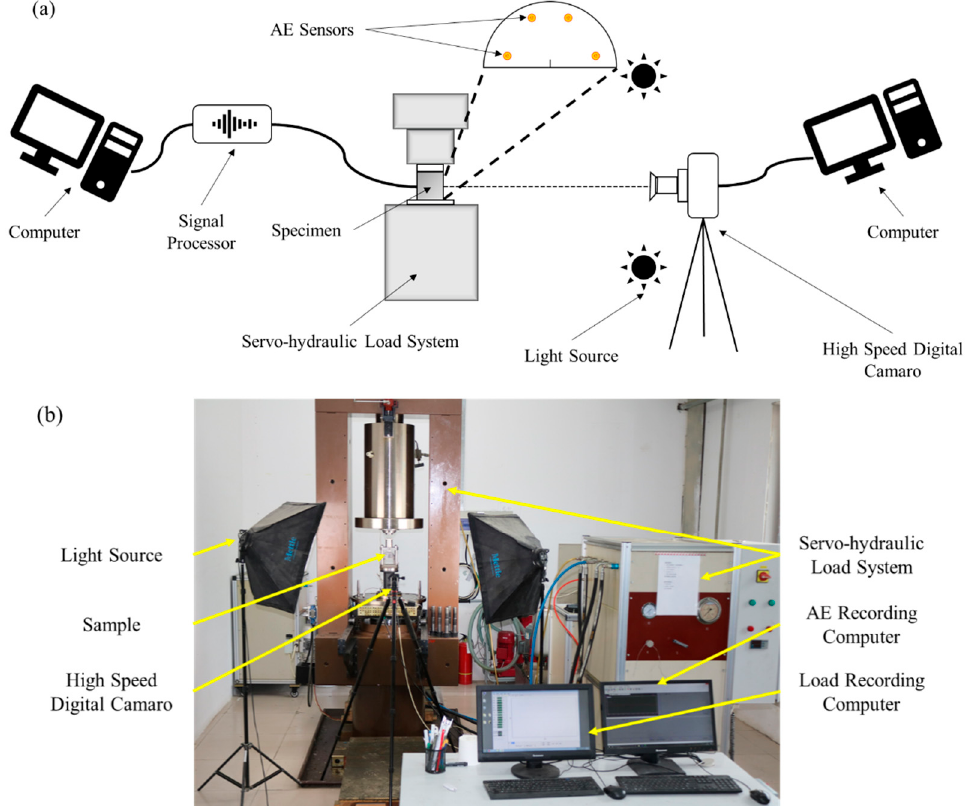
Figure 2. Digital image correlation system: ( a ) Schematic diagram; ( b ) Equipment photo.